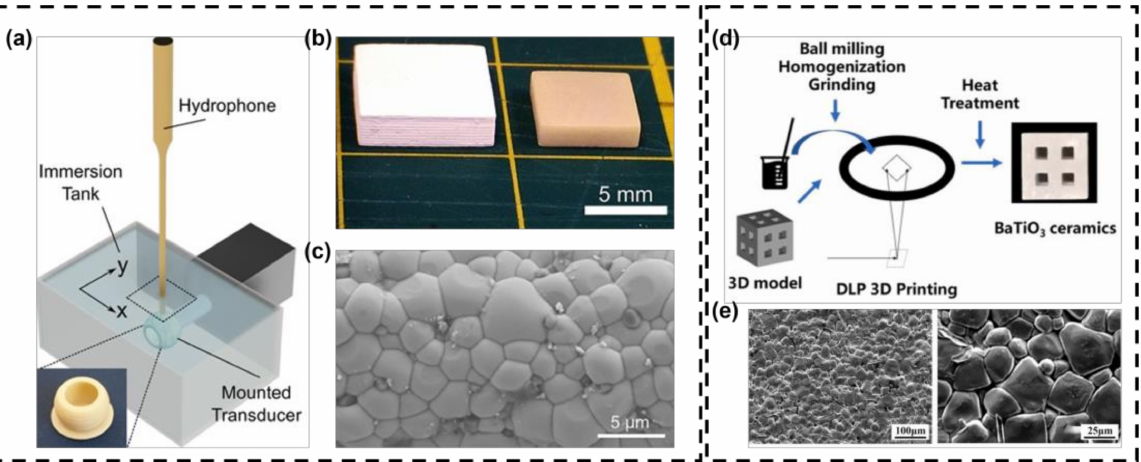
Figure 5. The 3D printing of two types of piezoelectric ceramics. ( a ) The schematic of an SLA 3D printing system for PMN-PT, ( b ) PMN-PT piezoelectric ceramics embedded within the polymer matrix (left), the corresponding sintered sample (right), and ( c ) the grain structure of the sintered sample [55] (Copyright 2015, John Wiley and Sons). ( d ) the schematic of the DLP 3D printing system employed to produce BTO ceramics. ( e ) The grain structure of sintered BTO ceramics [56] (Copyright 2022,